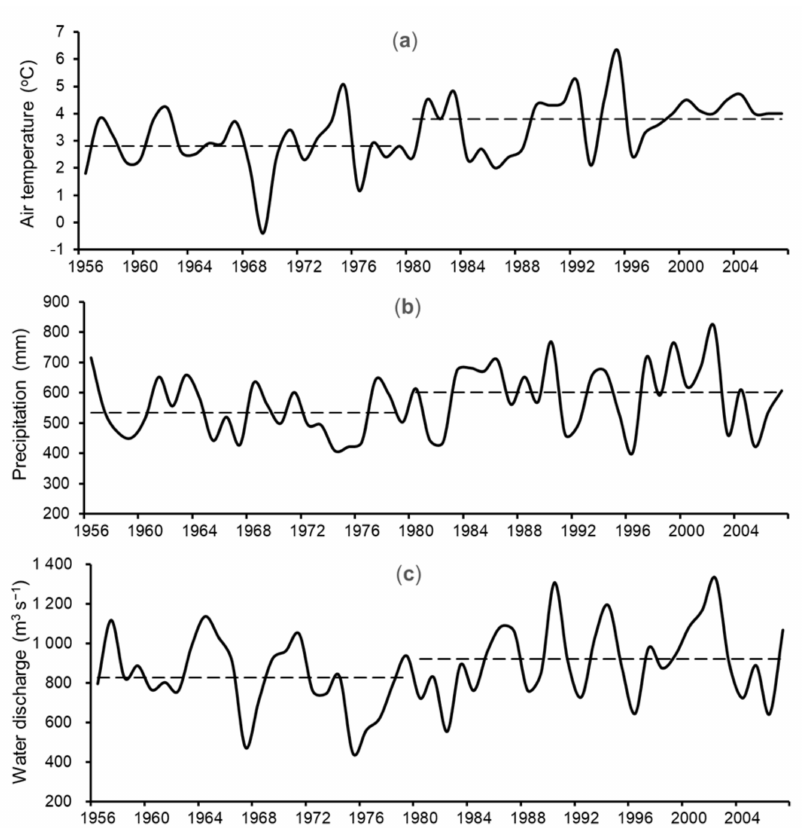
Figure 2. Changes in mean annual air temperature ( a ) and precipitation ( b ) in Ufa station and the mean annual discharges ( c ) of the Belaya River at Birsk gauge for the 1956–2007 period (dotted lines are